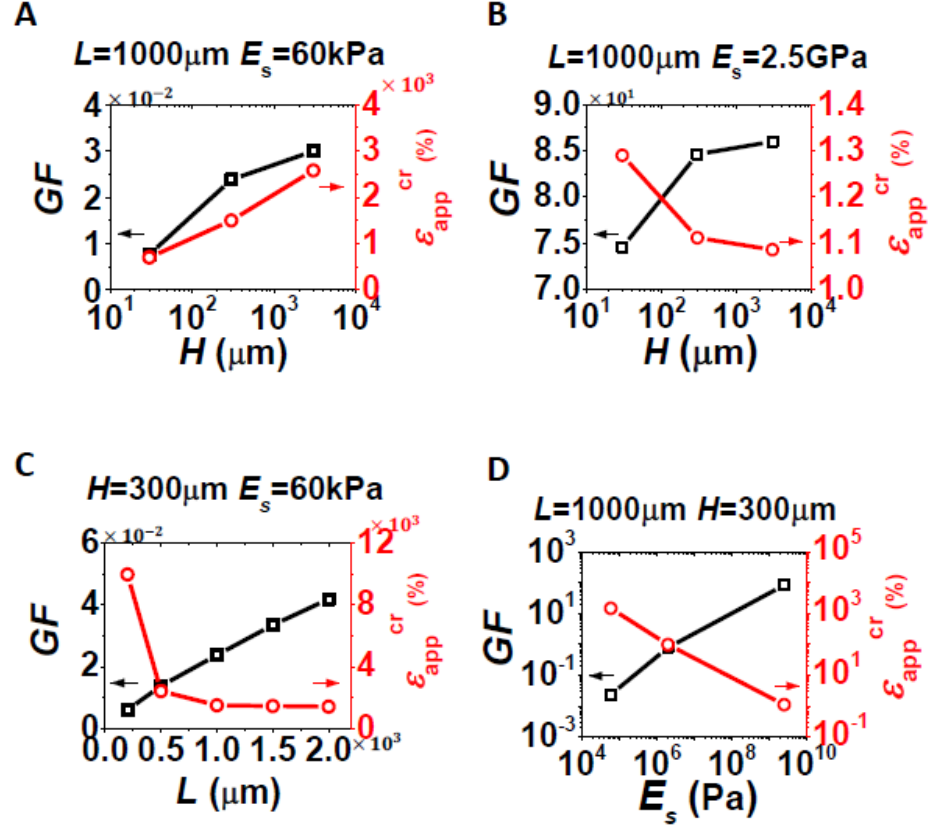
Figure 7. Tradeoff between GF and stretchability ( ε cr ): GF is plot in black with a vertical app axis on the left and stretchability is plot in red with a vertical axis on the right. ( A ) Effect of H when L = 1 mm and E = 60 kPa are fixed. ( B ) Effect of H when L = 1 mm and s E = 2.5 GPa are fixed. ( C ) Effect of L when H = 300 μm and E = 60 kPa are fixed. s s ( D ) Effect of E when L = 1 mm and H = 300 μm are fixed. Among the three variables, E s s has the widest range of options and hence the most significant